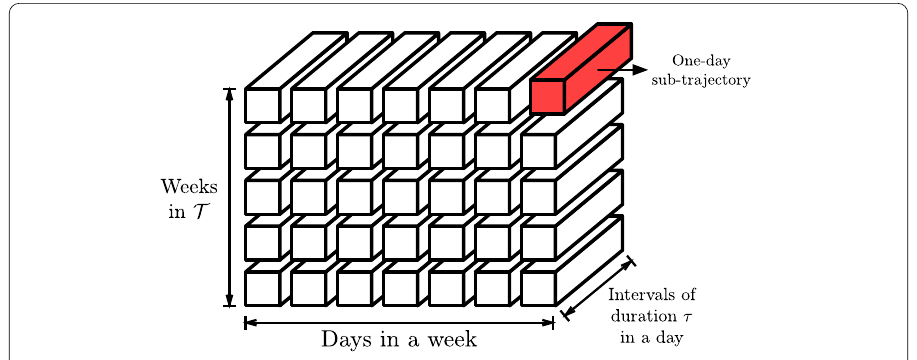
Figure 5 Example of the location tensor of a user X . A trajectory L T is represented as daily and weekly combinations of one-day